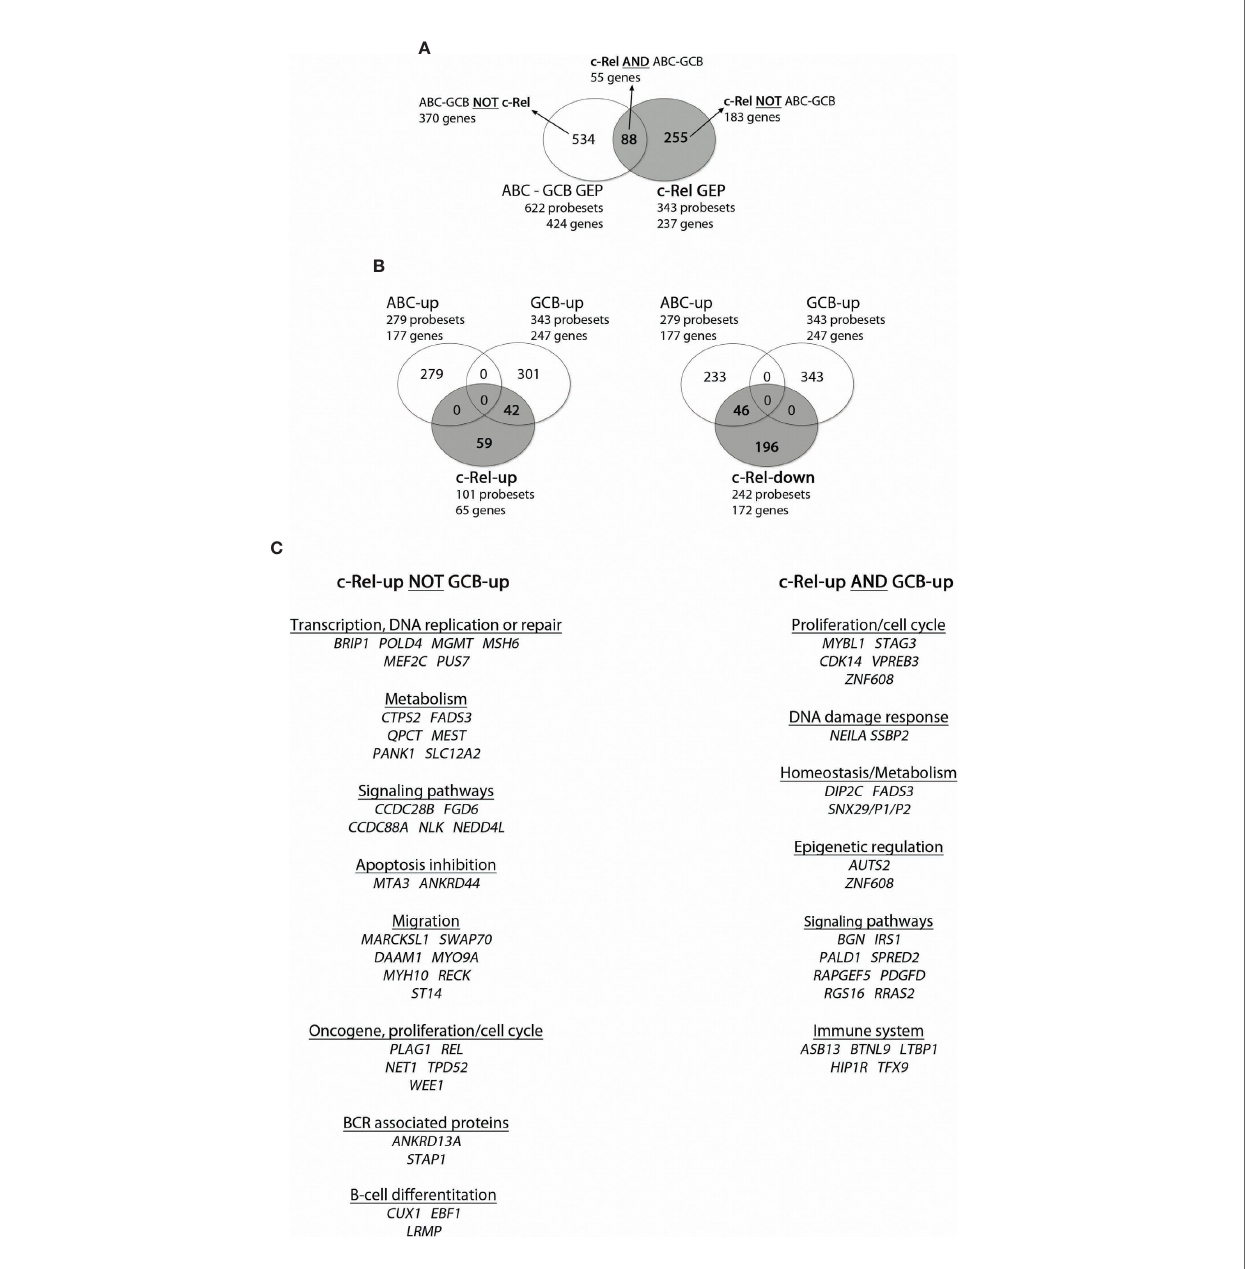
FIGURE 3 | Overlap between c-Rel and ABC-GCB gene expression pro fi les (GEPs). c-Rel GEP (237 genes, 65 up-regulated genes with 101 probesets, and 172 down-regulated genes with 242 probesets) and ABC-GCB GEP (424 genes, 177 up-regulated genes with 279 probesets, 247 down-regulated with 343 probesets) were established (fold change ≥ 2) from the 66 DLBCL cases of the GHEDI cohort for which the c-Rel DNA-binding pro fi le was established. (A) Venn diagram showing overlaps of probesets and genes between c-Rel GEP and ABC-GCB GEP. Set of genes named “ c-Rel AND ABC-GCB ” corresponds to the intersection between c-Rel and ABC-GCB GEP with 55 genes and 88 probesets (list in Supplementary Table S9 ). “ ABC-GCB NOT c-Rel ” are genes found in ABC-GCB GEP but not in c-Rel GEP. “ c-Rel NOT ABC-GCB ” are genes differentially expressed in c-Rel GEP but not in ABC-GCB GEP. This nomenclature is used in Figure 5 . (B) Venn diagrams showing overlap between c-Rel up-regulated genes (at left) or c-Rel down-regulated genes (at right) and ABC or GCB up genes. Indicated number corresponds to probesets that overlap or not. (C) c-Rel-up NOT GCB-up and c-Rel-up AND GCB-up gene lists. Genes are ordered related to their